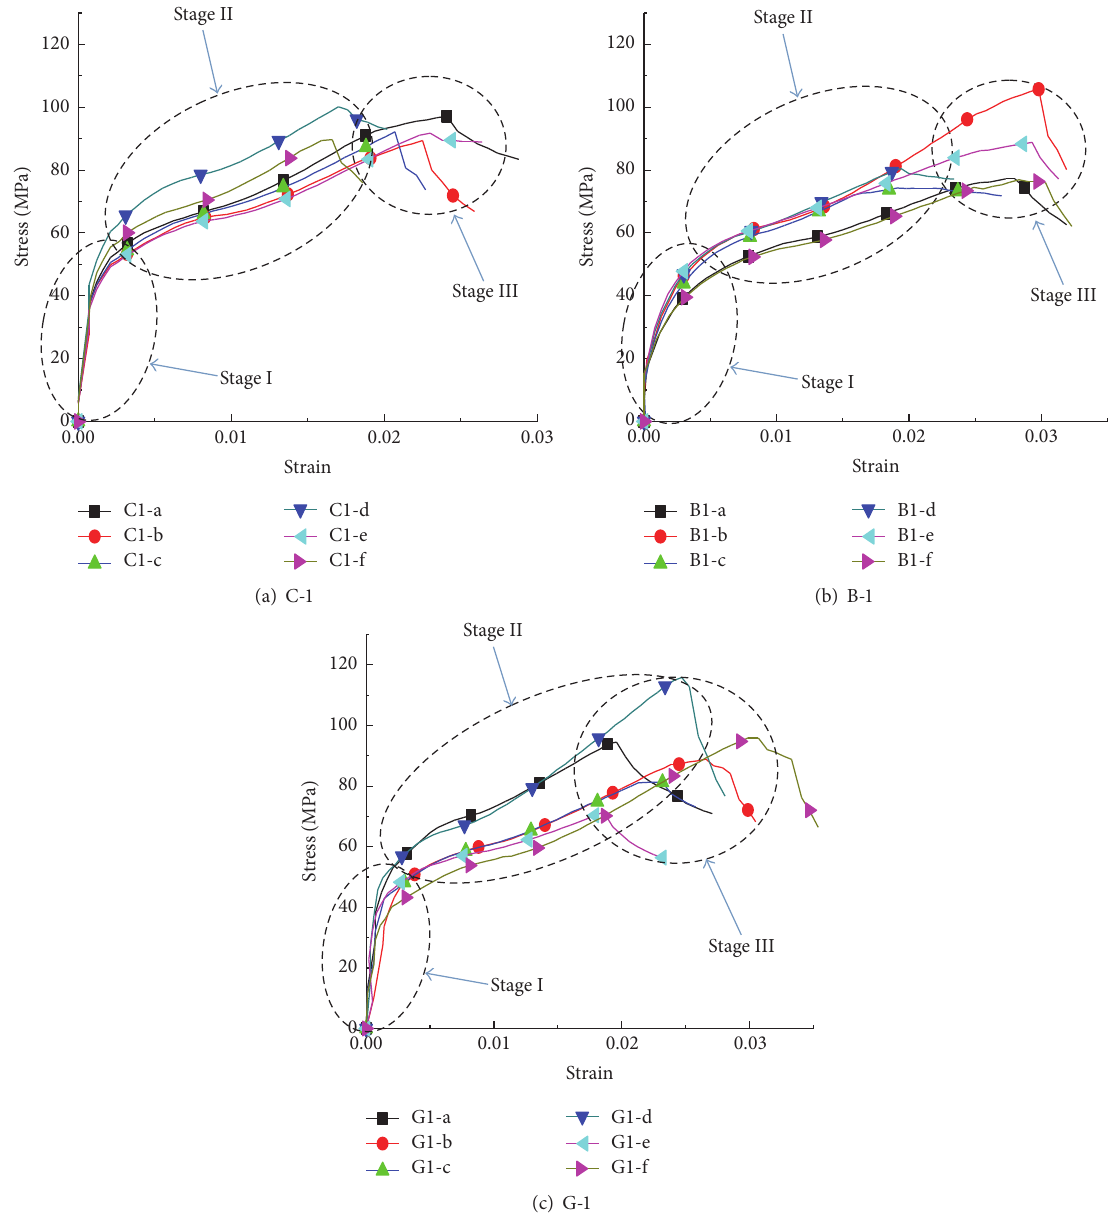
Figure 11: Stress-strain relationship